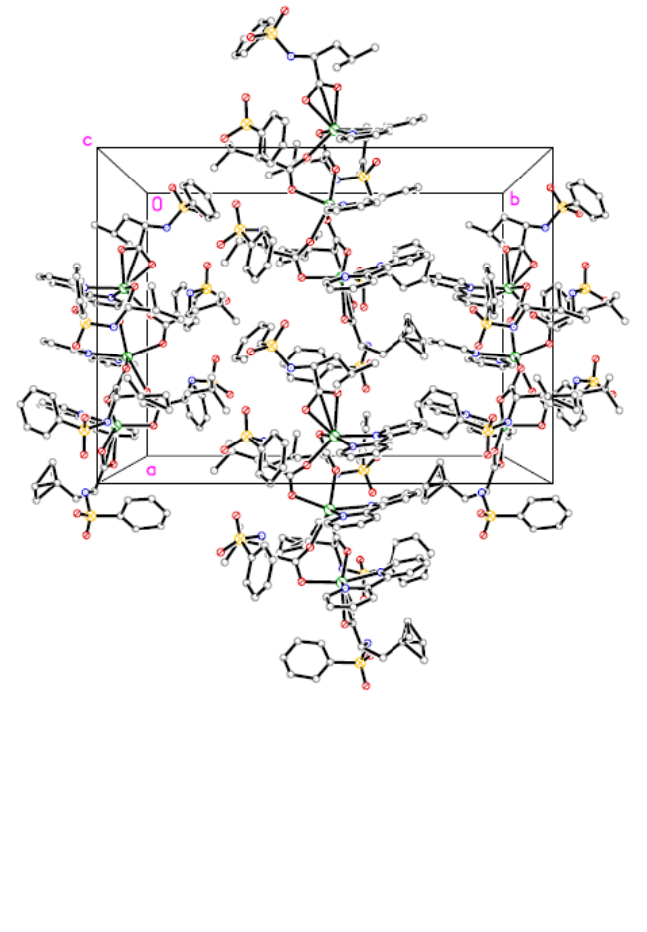
Figure 2. The molecular packing arrangement of the Cd (II)